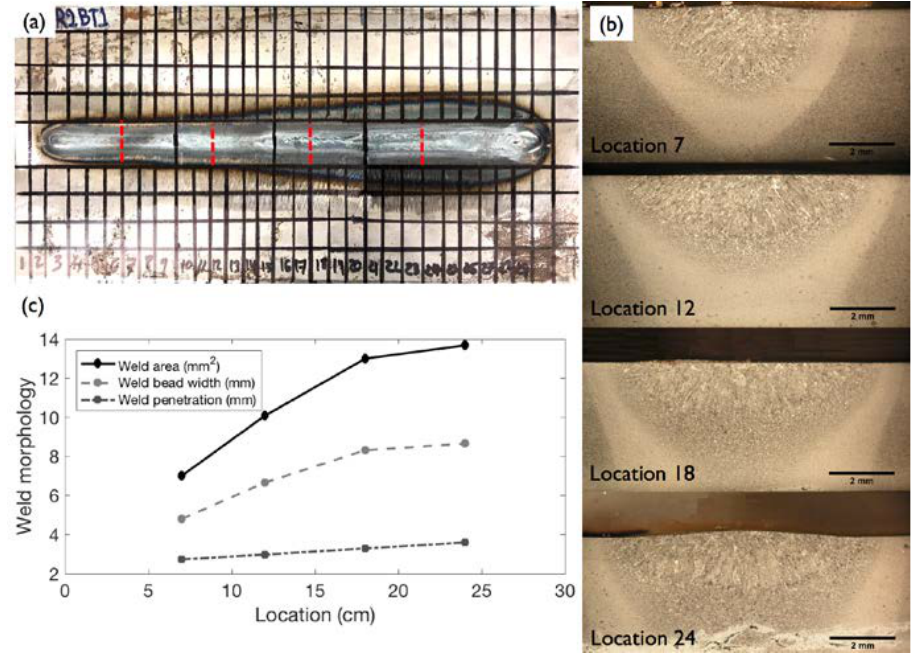
Figure 8. ( a ) Layout of weld coupon No. 1 showing the locations of the cross sections that were analyzed; ( b ) weld cross section characteristics and microstructures; and ( c ) weld width and weld area measurements.